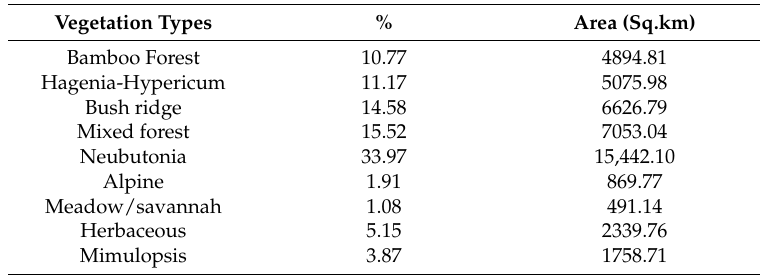
Table 3. Vegetation types in the Virunga Volcanoes and their specific area of coverage. Vegetation Types